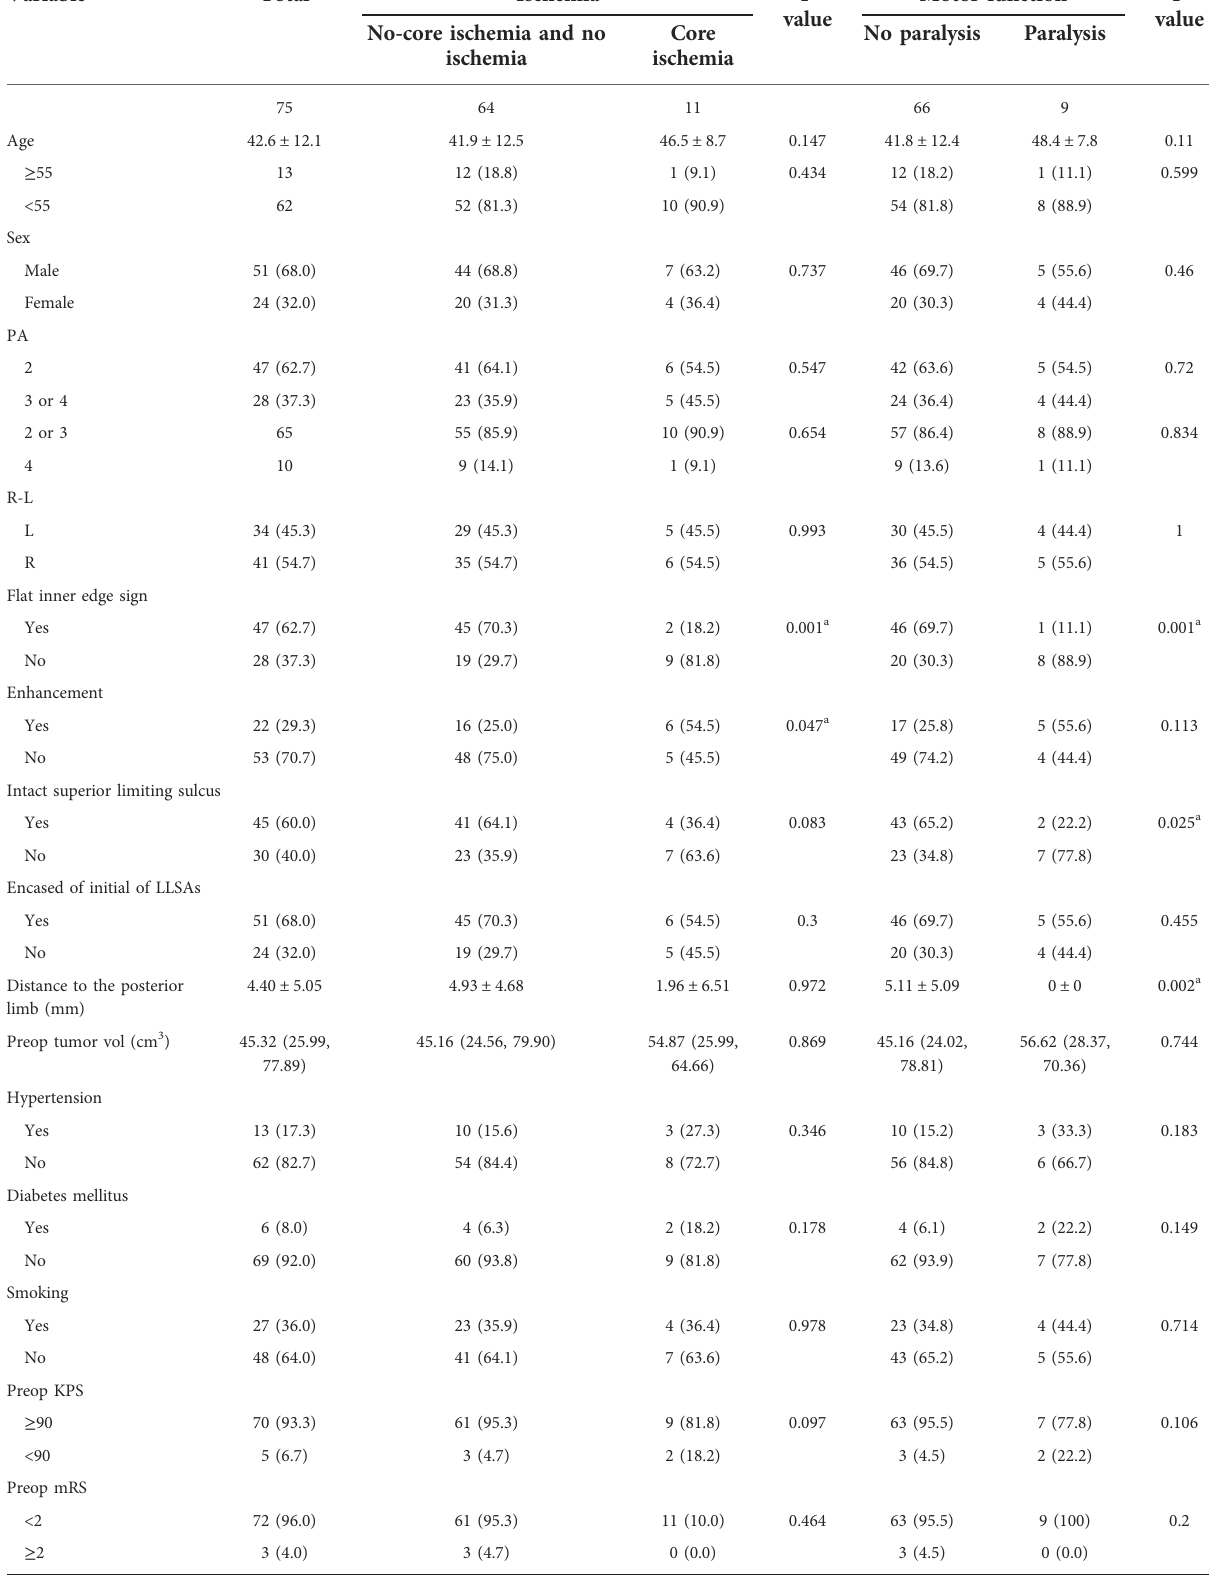
TABLE 1 Comparison of baseline demographics and clinical characteristics of patients with and without core ischemia and paralysis.